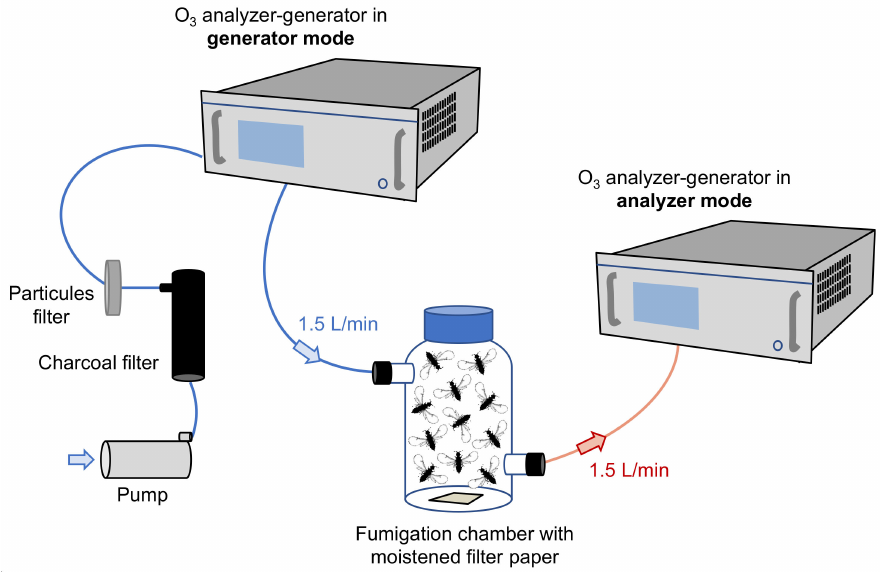
Figure 1. Experimental setup for the controlled and continuous flow during O 3 exposure of fig wasps at 0, 40, 80, 120, or 200